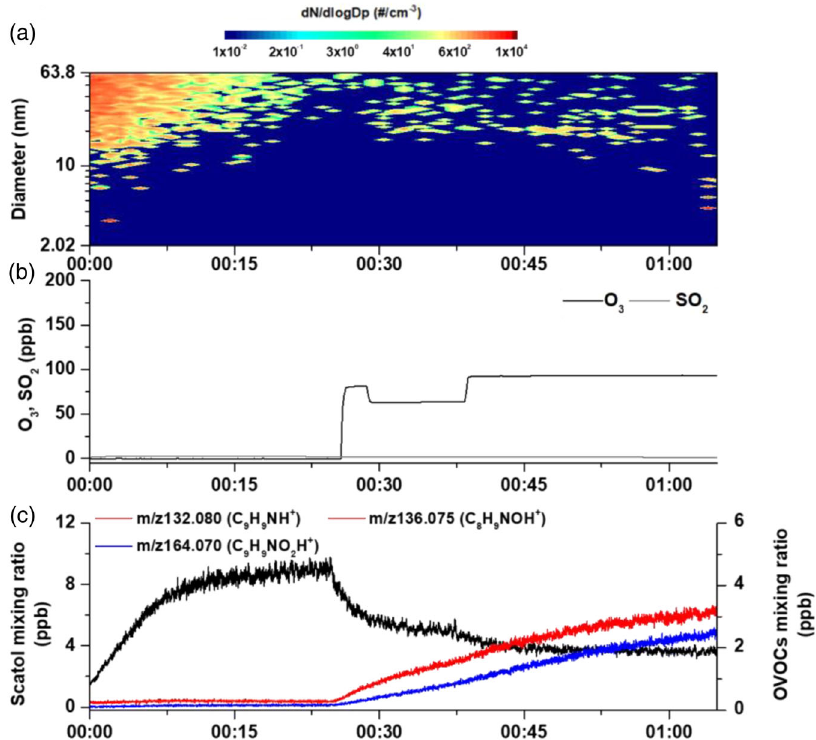
Fig. 3 Non-emitting SO 2 sewage sludge ozonolysis experiment. a Temporal evolution of the particle number concentration and size distribution. The ordinate represents the electrical mobility diameter (nm), and the color scale represents the particle number concentration. b Temporal evolution of O 3 entering the chamber (black line, O 3 in) and SO 2 (gray line). c Temporal evolution of m/z 132.080 C 9 H 9 NH + (black line, left axis), m/z 136.075 C 8 H 9 NOH + (red line, right axis), and m/z 164.070 C 9 H 9 NO 2 H + (blue line, right